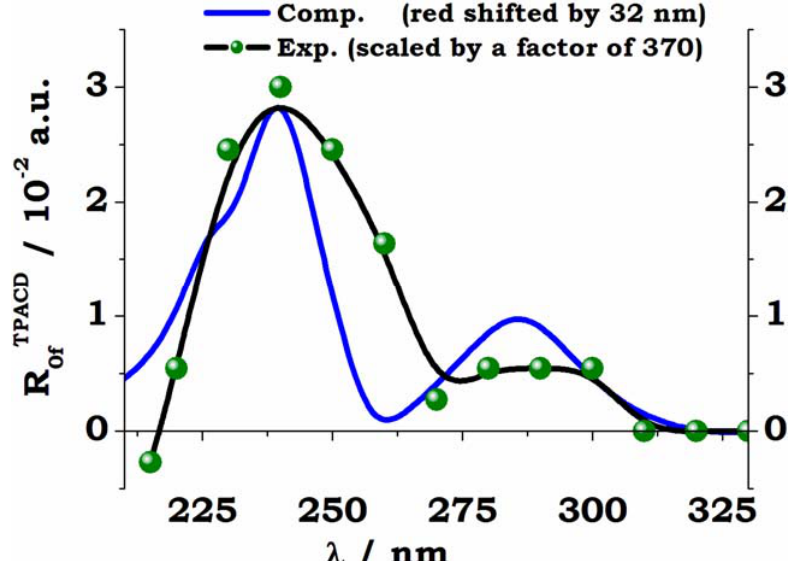
Figure 11. TPCD. Two circularly polarized photons. Comparison of experimental (black curve, B-spline interpolation of the experimental points) and theoretical (blue curve, PCM/DFT/CAM-B3LYP results, aug-cc-pVDZ basis set) for R -BINOL in THF. In the abscissa the one-photon wave length. Gaussians functions = 0.3 eV employed for the simulation, fee Ref.